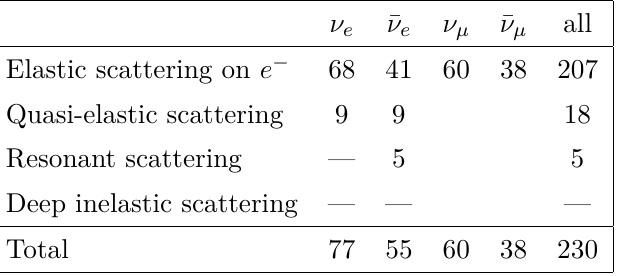
Table 5. Expected neutrino background yield to light dark matter elastic scattering search in the SHiP experiment, corresponding to 2 × 10 20 delivered p.o.t. The current estimate is the result of a combined geometrical, topological and kinematical selection, aimed at identifying only interactions occurring within the Scattering Neutrino Detector with one visible track in the final state being an electron. Tracks under a defined visibility threshold are discarded ( p < 100 MeV/c for charged, p < 170 MeV/c for protons). A kinematic cut in E e ∈ [1 , 5] GeV and θ e ∈ [10 , 30] mrad of the scattered electron is chosen as result of the signal significance optimisation procedure and determines the final number of background events. We refer to the section 5 for further details on the analysis and the associated